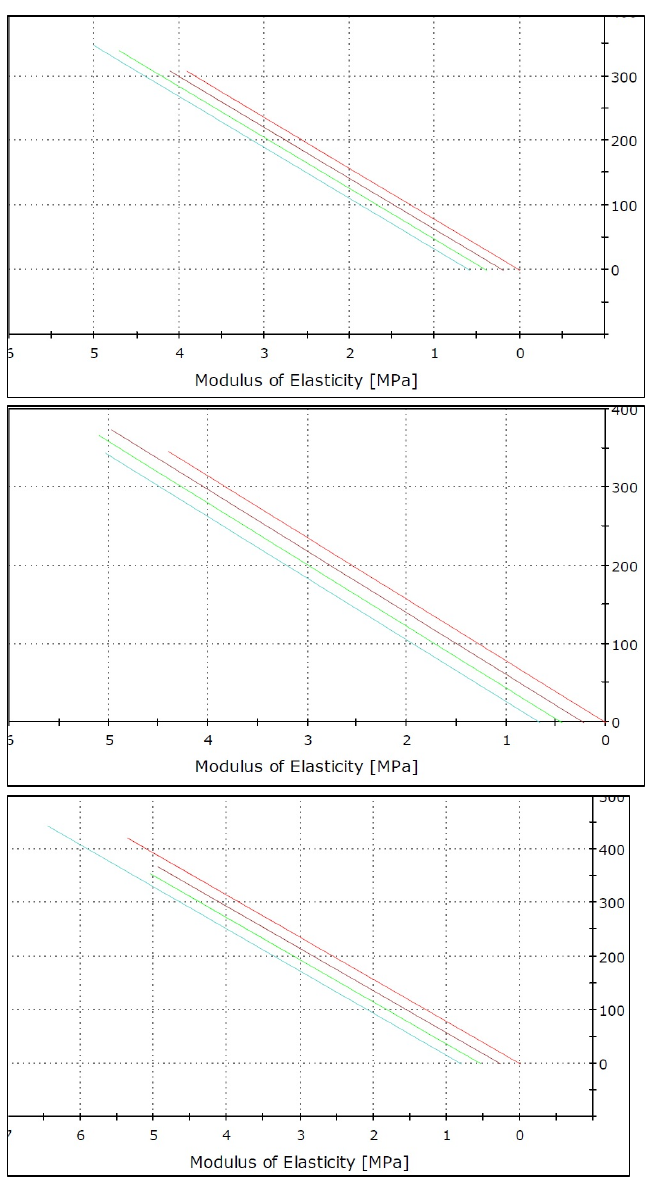
Figure 5. Modules of elasticity forces by ANOVA test among different ceramic materials.